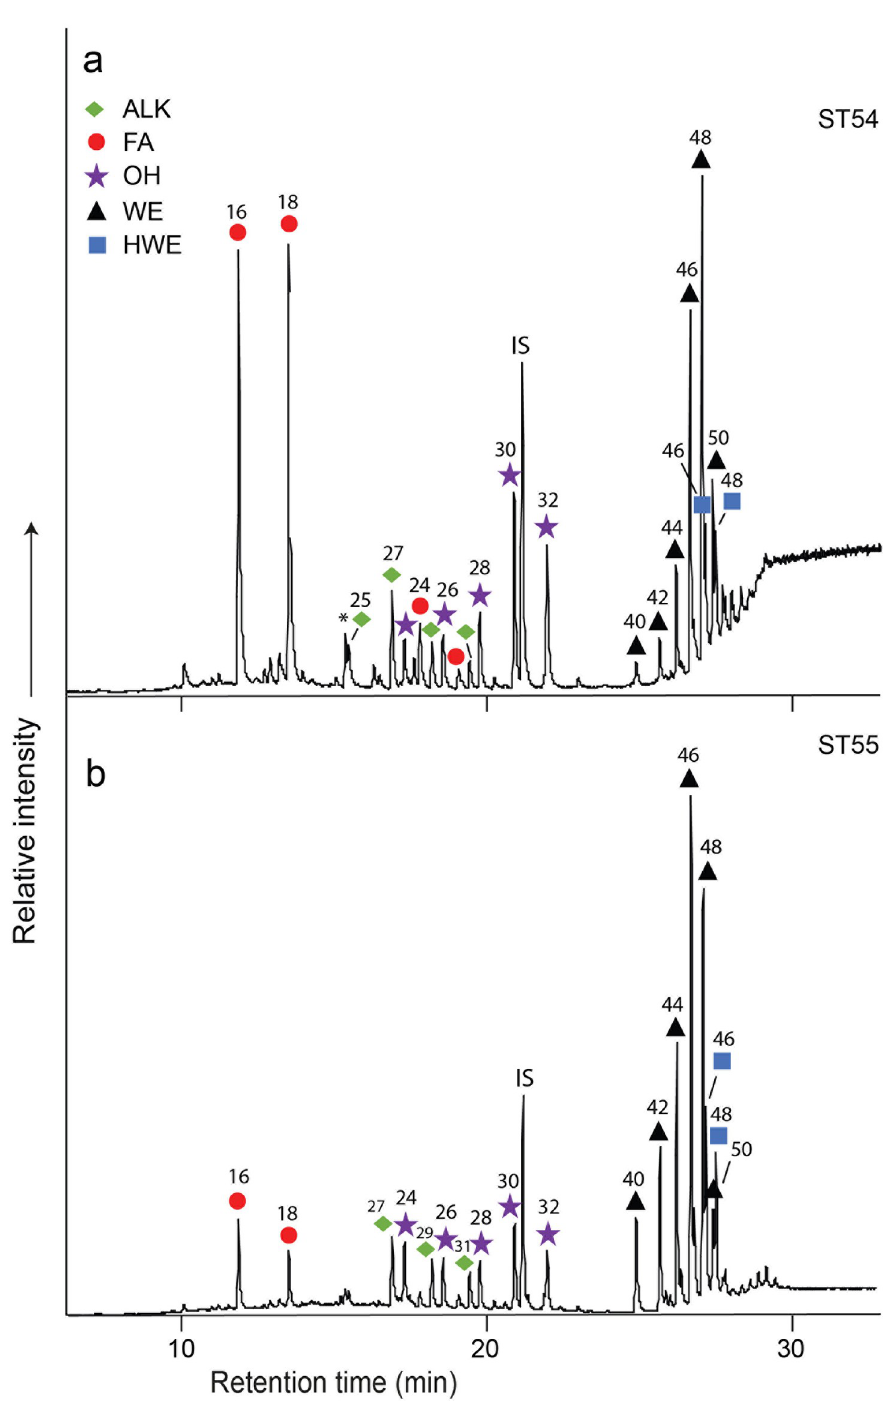
Fig 4. Partial high-temperature gas chromatograms of trimethylsilylated TLEs from the pottery extracts ST54 and ST55 containing beeswax. Red circles, n -alkanoic acids (fatty acids, FA); green rhombus, n -alkanes (ALK); purple star, n -alkanols (OH); black triangles, fatty acyl monoesters (WE); blue squares, hydroxyl fatty acyl monoesters (HWE) and IS, internal standard, C34 n-tetratriacontane. High abundances of C 16 and C 18 fatty acids, particularly potsherd ST54, are interpreted as originating from mammalian animal